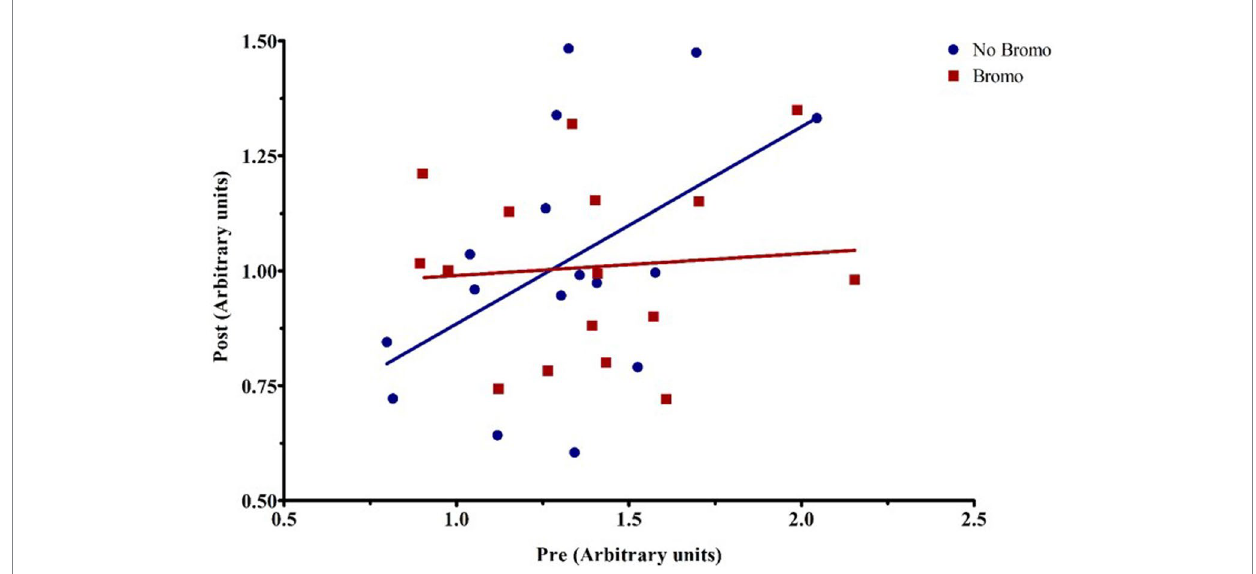
FIGURE 5 Representative graph of the interaction between pre-infusion levels of total 4E-BP1 and bromocriptine treatment on post-infusion levels of total 4E- BP1. For covariate analysis, pre and its treatment interactions were first tested as fixed effects (pre, pre x bromo, pre x implant, and pre x bromo x implant) to determine which covariates were significant ( p < 0.05). Insignificant covariates were dropped from the model. The pre x bromo interaction was significant ( p = 0.003), demonstrating that pre glucose infusion levels of total 4E-BP1 affected the amount of total 4E-BPI found post infusion in animals treated with bromocriptine. There was a positive relationship between pre-and post-infusion abundance in steers not treated with bromocriptine (blue fitted line), but in the presence of bromocriptine (red fitted line), there was no relationship between pre-and post-infusion total protein abundance. Each point represents an individual